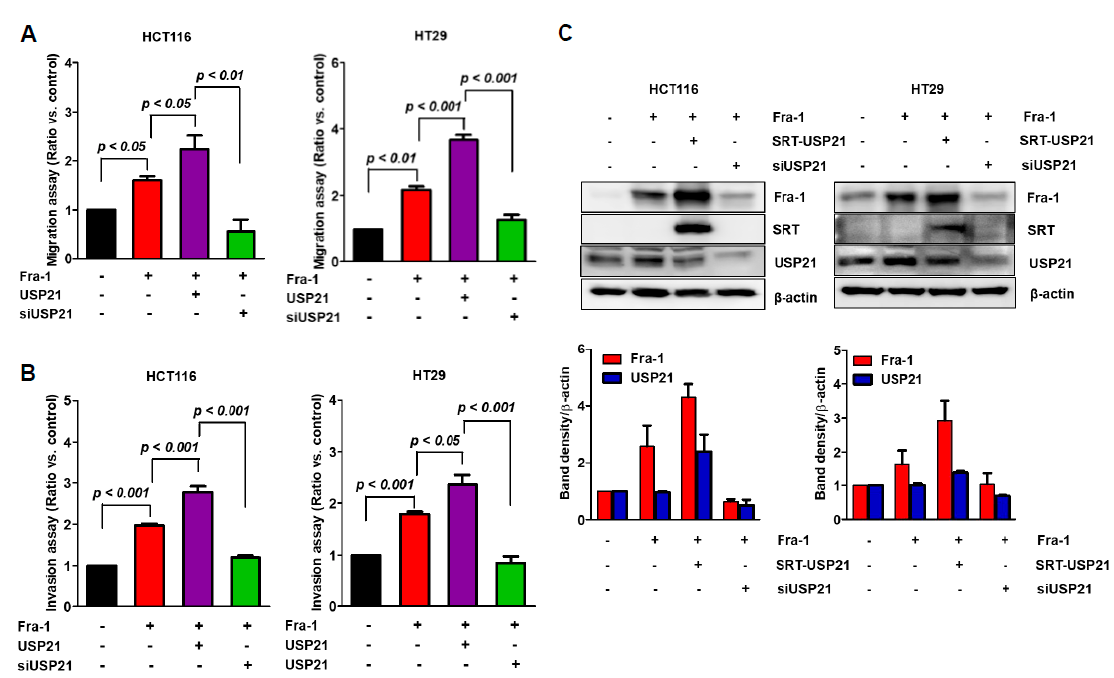
Figure 5. USP21 is related to cancer cell activity. ( A – C ) HCT116 and HT-29 cells were co-transfected with or without SRT-USP21 and Fra-1 plasmids for 24 h. Fra-1 plasmid was co-transfected with or without USP21 knockdown in each cell line. Transfected cells were subjected to ( A ) migration assays for 24 h and ( B ) invasion assays for 48–72 h. Data shown are average values from three independent experiments. Data were statistically analyzed by one-way ANOVA ( n = 3). ( C ) Total cell lysates were analyzed by immunoblot analysis with the indicated antibodies. Band intensities of Fra-1 and USP21 were quantified as shown in the graph below ( n = 2).